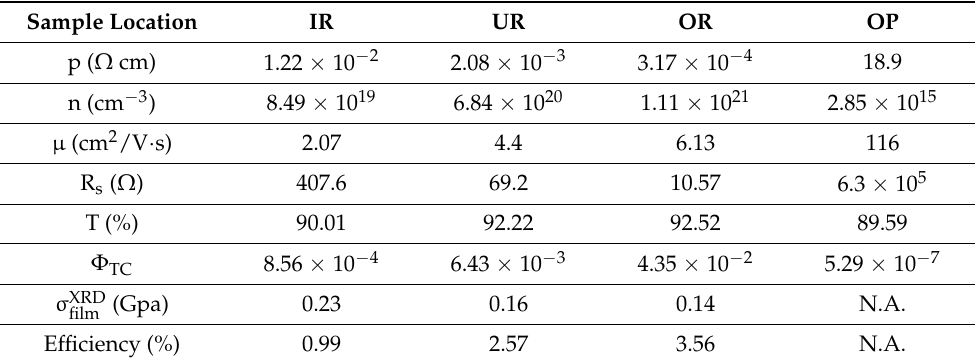
Table 1. Characteristics of AZO film in different deposition regions and the corresponding efficiencies when applied to CZTSe solar